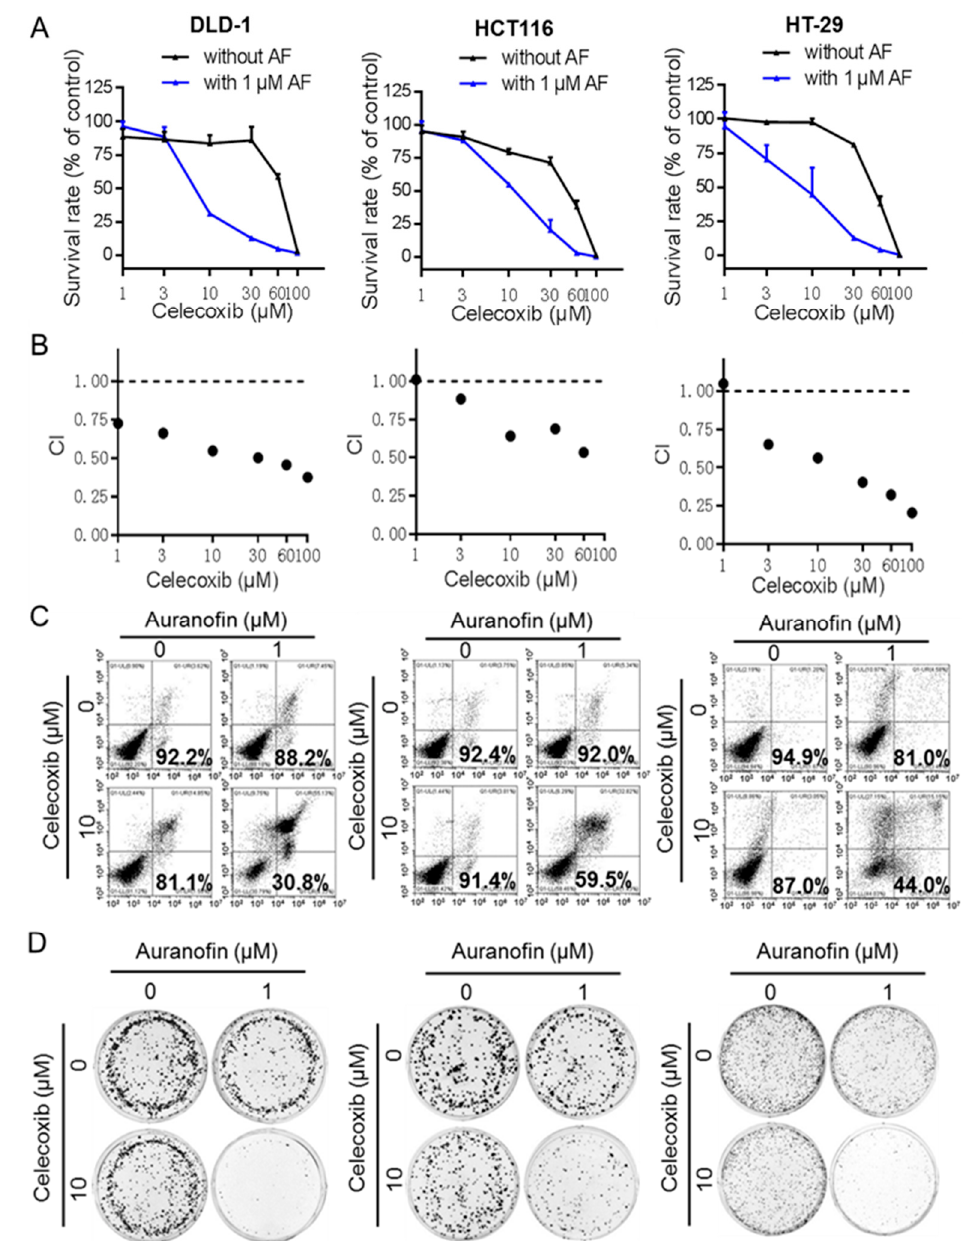
Figure 2. Auranofin and celecoxib synergistically induce colorectal cancer cell death in vitro. ( A ) Dose–response curves of celecoxib with or without 1 μ M auranofin for the indicated cells. Data are presented as the mean ± standard deviation (SD) of a triple assay. Cells treated with DMSO alone were used as controls, and their values were set as 1. ( B ) Combination index (CI) of celecoxib and auranofin in the indicated three cell line cells as described in A was analyzed by using CalcuSyn Version 2.0 software (Biosoft). CI > 1 indicates antagonist effect; CI = 1 indicates additive effect; CI < 1 indicates synergistic effect. ( C ) Apoptosis induced by AF (1 μ M) and combination with celecoxib (10 μ M) for 48 h was detected by annexin V/PI double-staining followed by flow cytometric analysis in the indicated three cell lines. ( D ) The colony formation assay of three cancer cell lines treated with indicated conditions of AF and CE for 2 weeks.